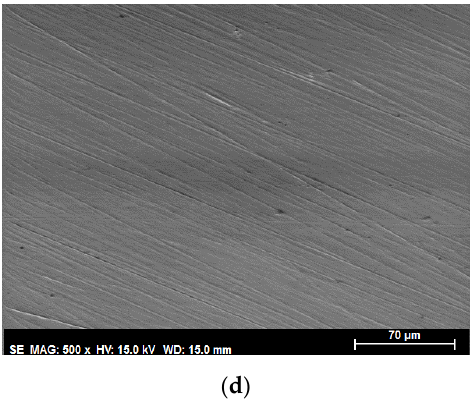
Figure 8. SEM micrographs of wear tracks on AISI 316L after the tribological tests: ( a ) IL; ( b ) IL thin film; ( c ) IL + G; ( d ) IL + G thin film.